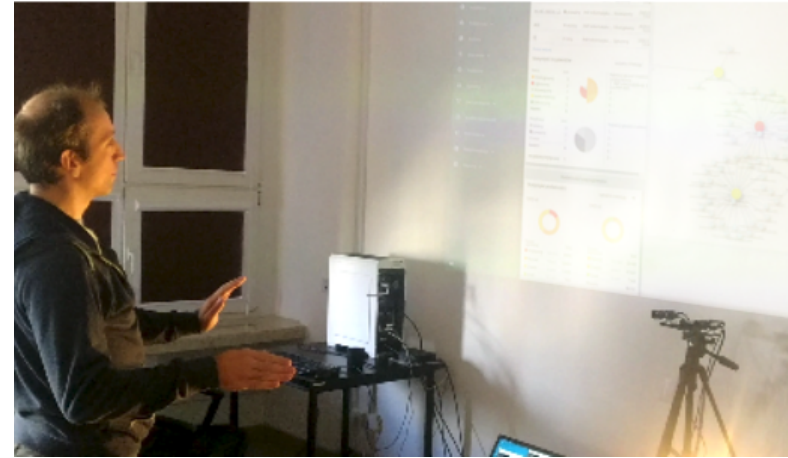
Figure 2. A smart human–computer interface (HCI) for on-line data